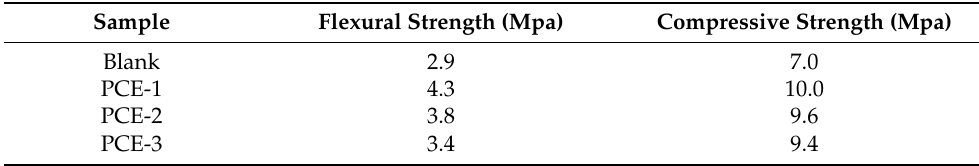
Table 2. Compressive and flexural strength of samples with